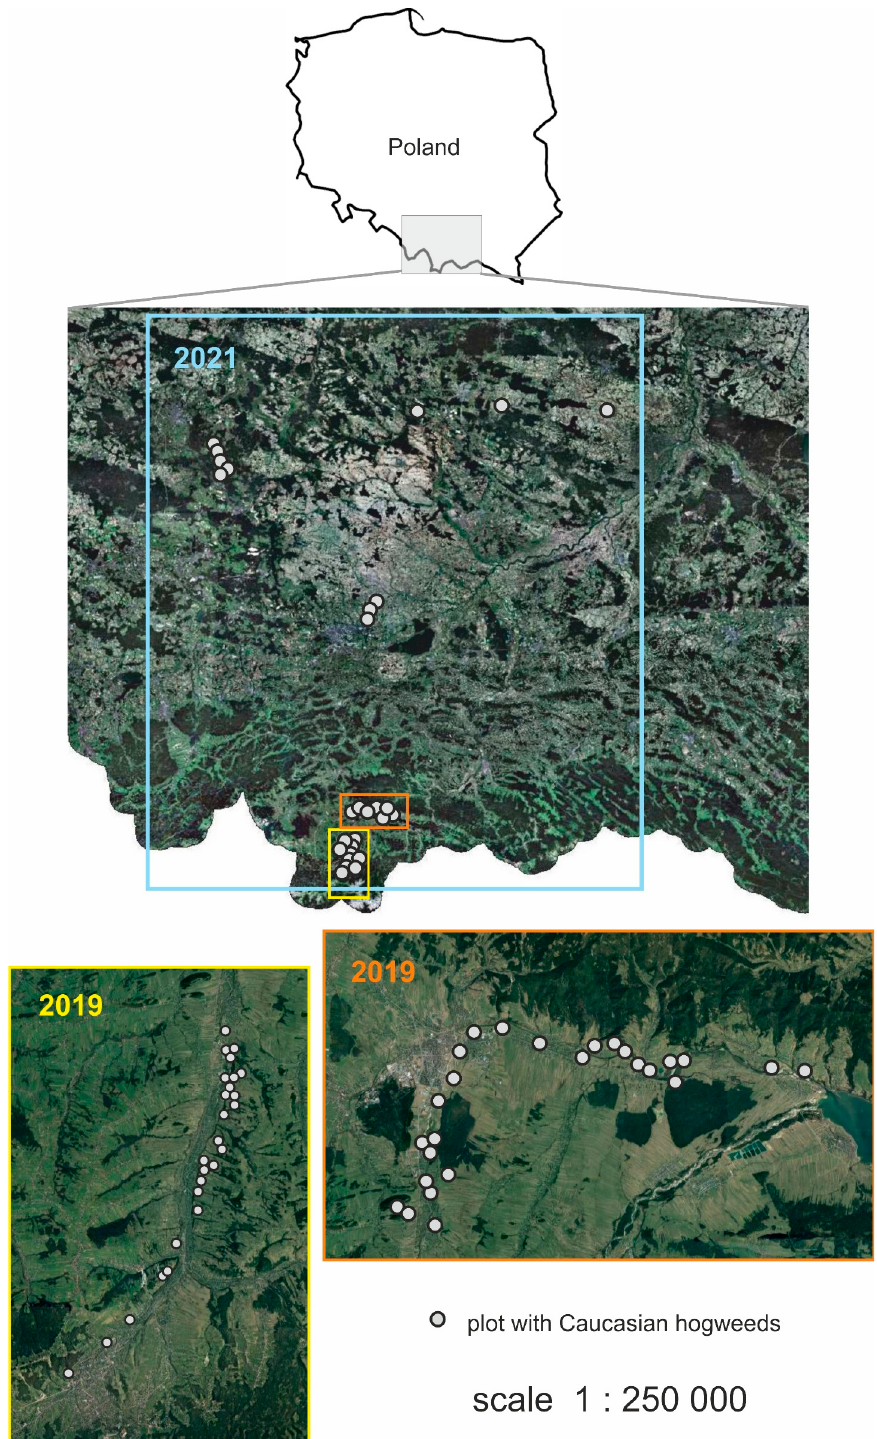
Figure 2. Map of the study plots with Caucasian hogweeds (N = 52 from 2019, N = 28 from 2021) in South-Eastern Poland. Free background source: geoportal.gov.pl (accessed on 19 January 2022).